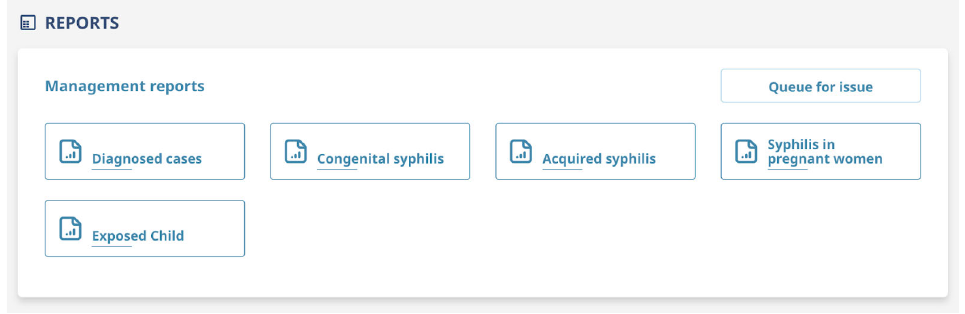
Figure A3. Geolocation.